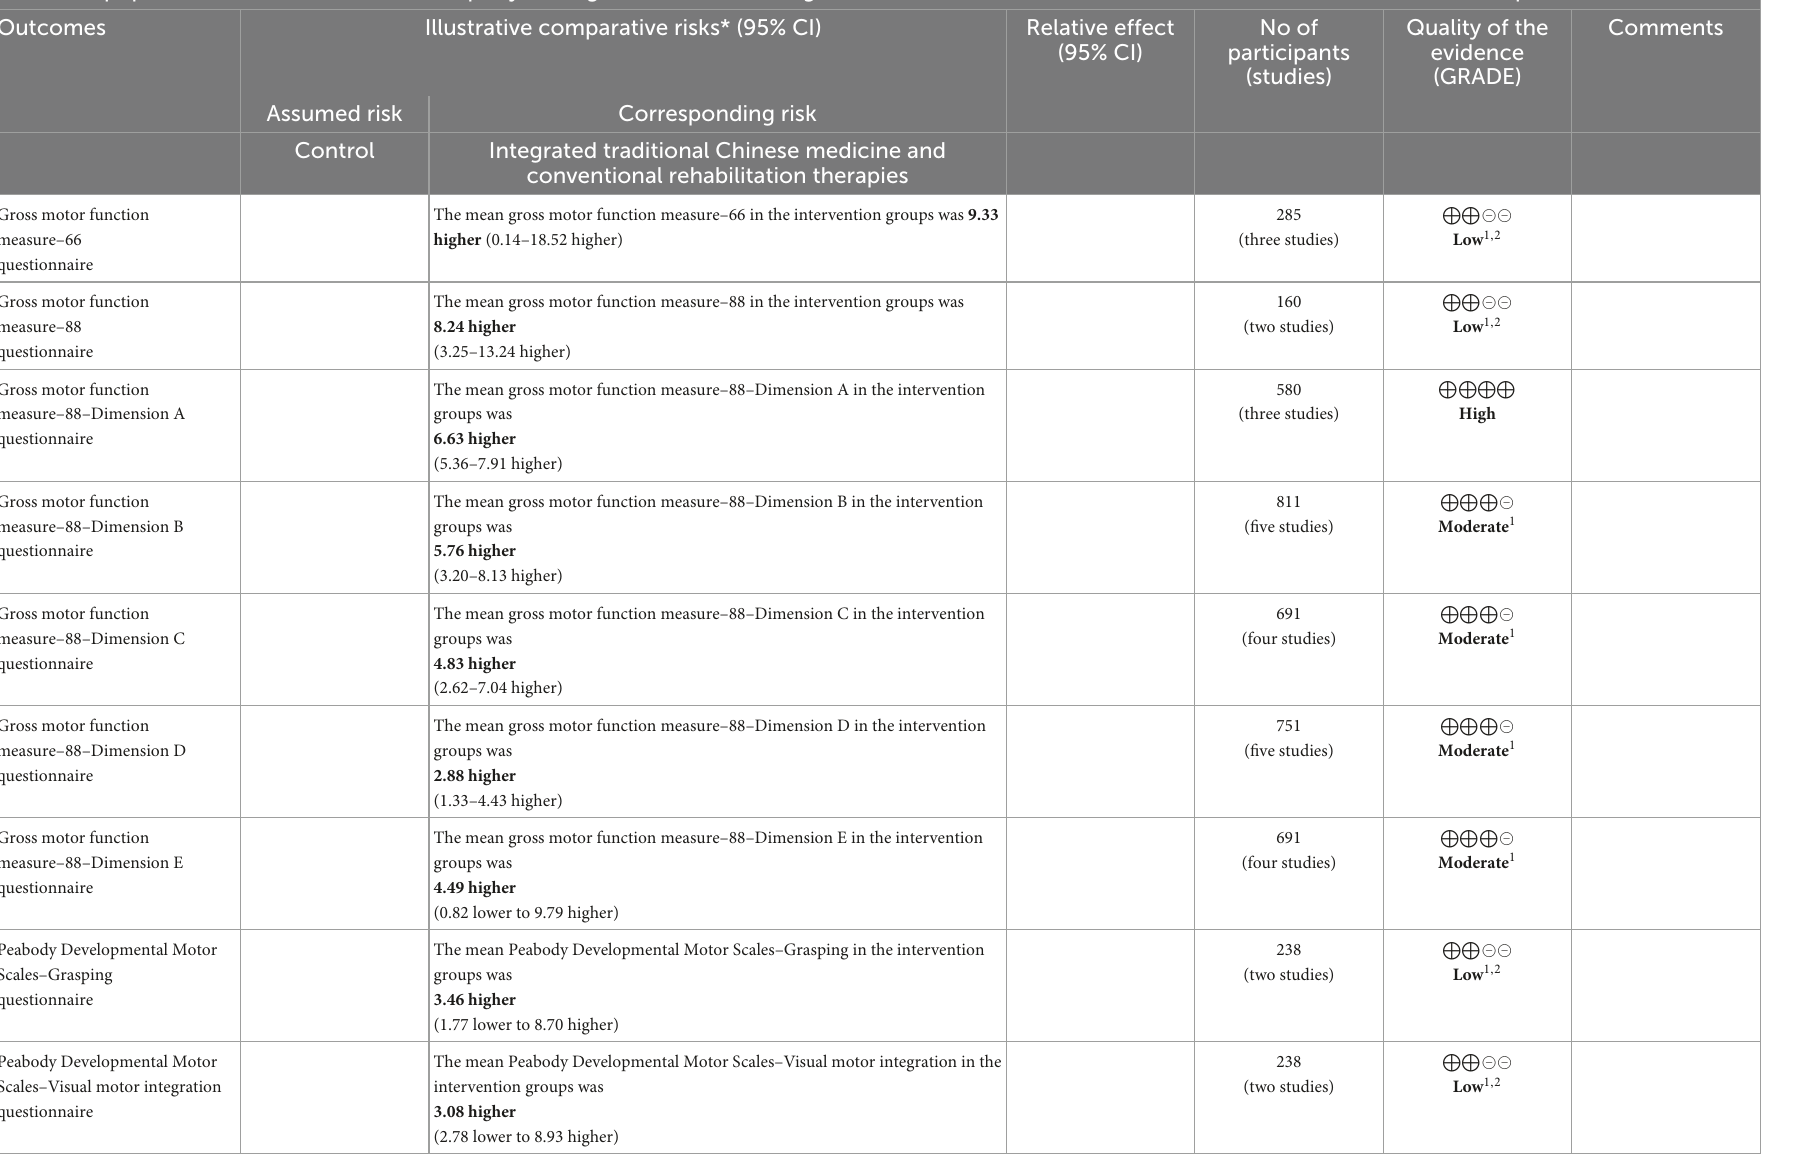
TABLE 4 Quality of evidence measured by grading of recommendation assessment, development, and evaluation. Patient or population: Children with cerebral palsy Settings: Intervention: Integrated Traditional Chinese medicine and modern rehabilitation therapies